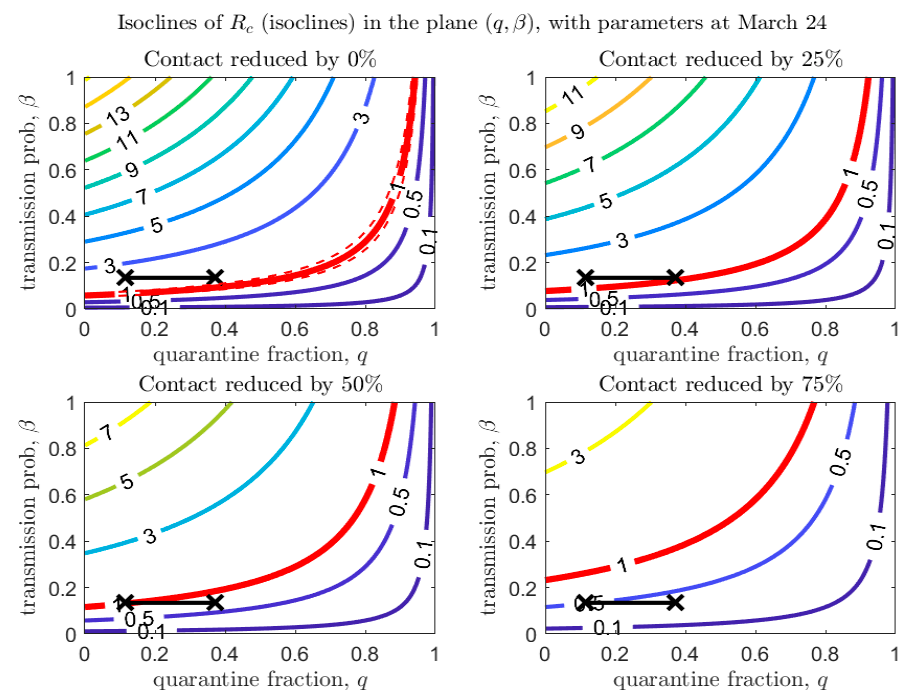
Figure 6. Same as Figure 4, with baseline parameters estimated in the period before March 14.